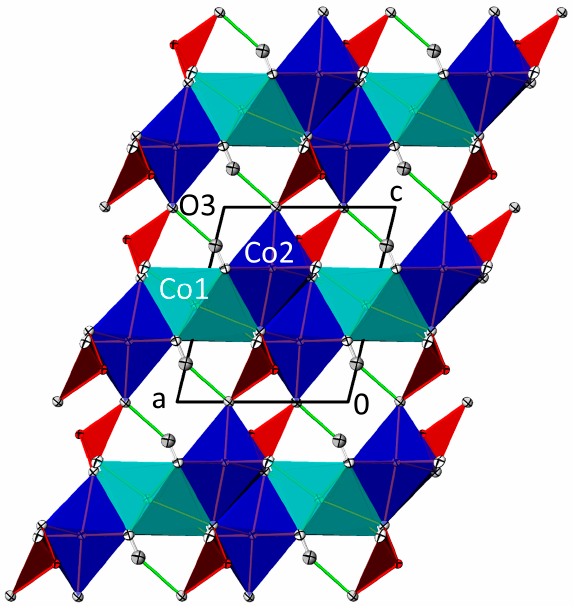
Figure 3. The crystal structure of Co 2 (TeO 3 )(OH) 2 in a projection along [010]. [TeO 3 ] polyhedra are red; O − H···O hydrogen bonding interactions are indicated by green lines. Other color codes and displacement ellipsoids are as in Figure 2.